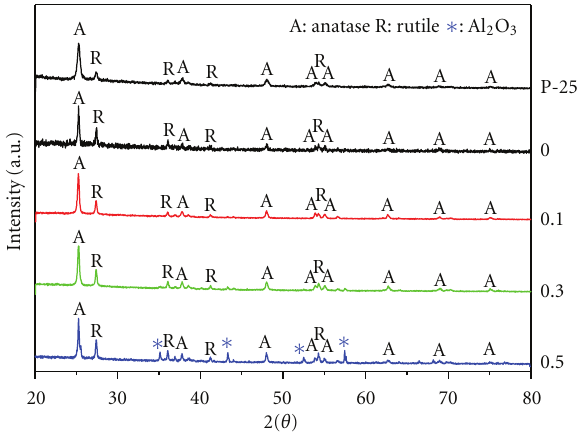
Figure 3: XRD patterns of TiO 2 nanoparticles synthesized at Al 2 O 3 /Ti = 0 to 0.5 and Degussa P-25.